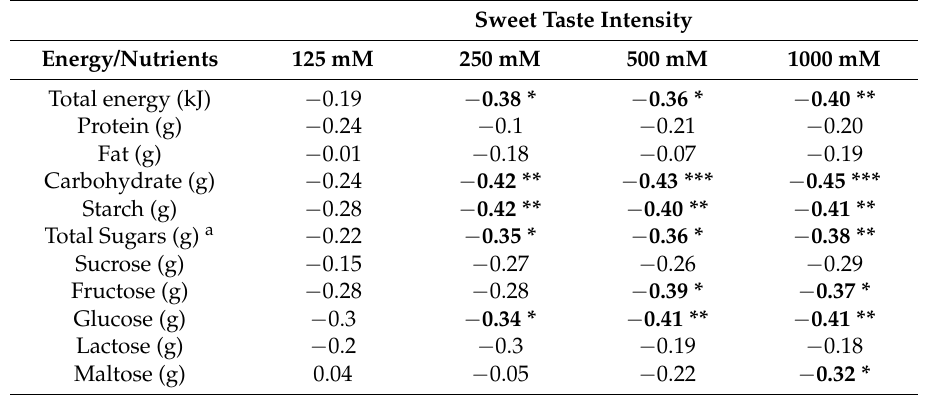
Table 6. Correlation coefficients of the relationship between sweet taste intensity and food